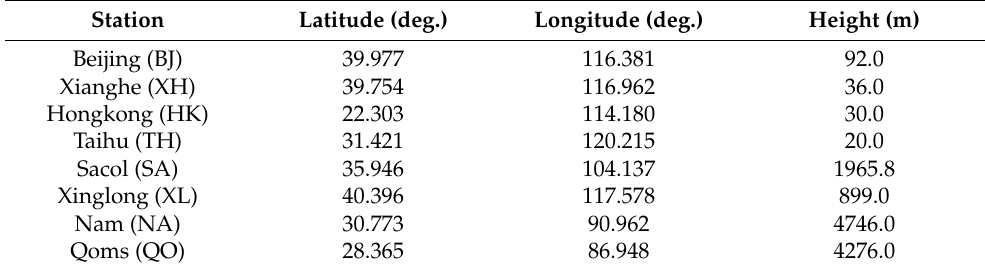
Table 2. Geographic information of the AERONET stations